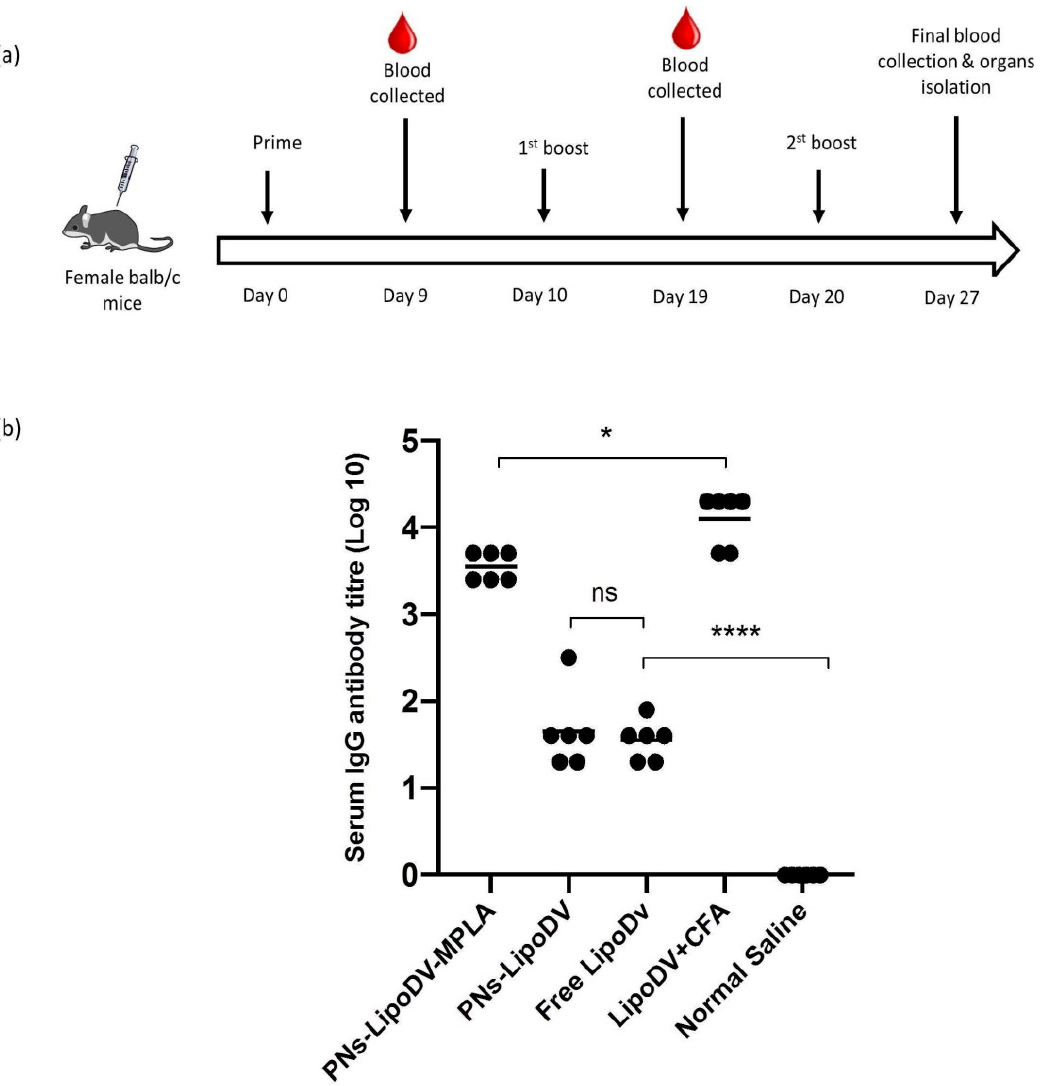
Figure 5. ( a ) Timeline of immunization and sample collection. Balb/c mice were subcutaneously immunized thrice in a 2-weeks interval. ( b ) Antigen-specific IgG antibody titers derived from the final blood collection sample after thrice vaccinations dose regime Each point in the figure represents an individual mouse in the group (n = 5). The mean antigen-specific IgG titers are represented as a bar. Statistical analysis was performed using one-way ANOVA followed by a post hoc test (Tukey) between the group as necessary. (ns, p > 0.05; * p < 0.05; **** p < 0.0001).